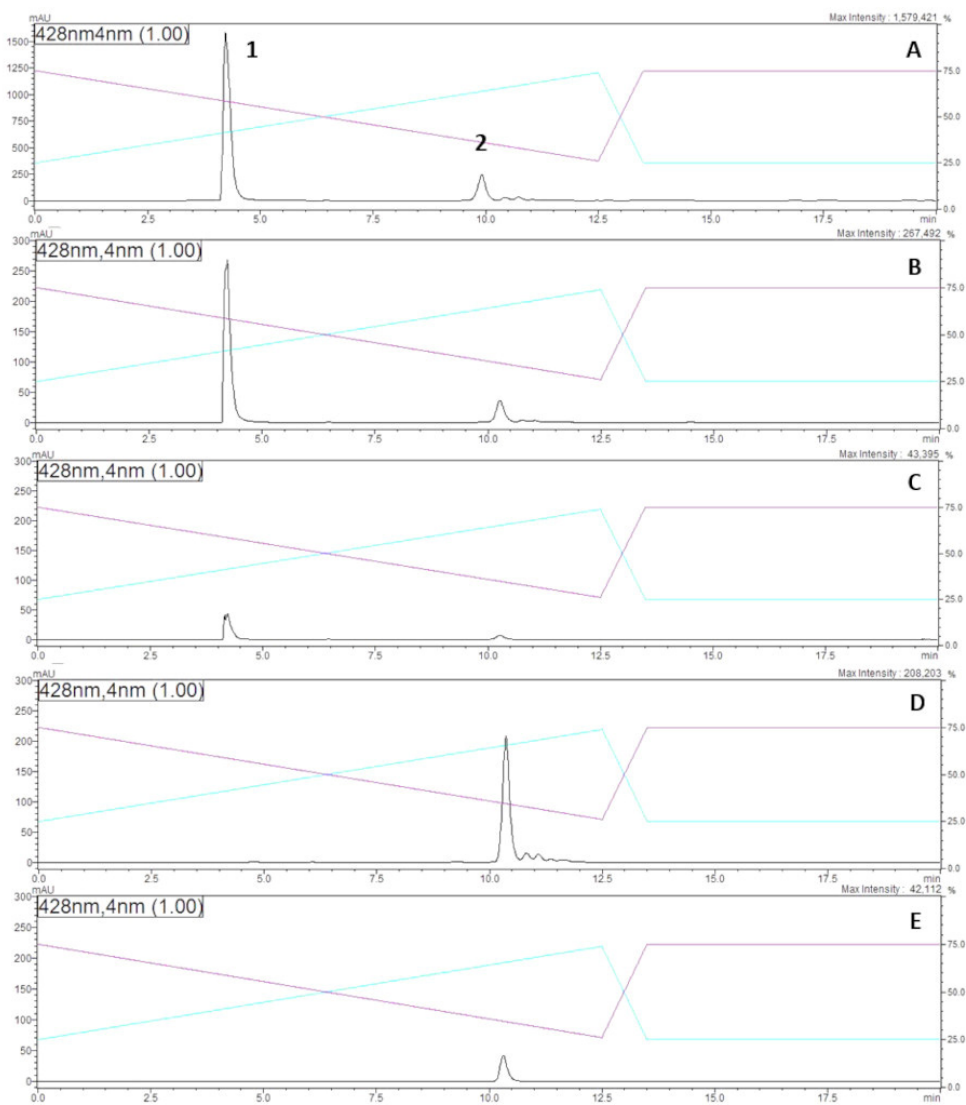
Figure 4. Semi-preparative HPLC-DAD chromatograms of SPE-purified crude methanol extract of Epicoccum nigrum recorded at 428 nm using a C18 column. Pink line: eluent A (H 2 O at pH 10); blue line: eluent B (methanol:isopropanol 8:2 v / v ). A : Two major peaks containing yellow compounds were observed at 4 min (peak 1) and 9.5 min (peak 2), in addition to a few minor peaks. B : Re-injection of peak 1 (from A ) dissolved in pure methanol. C : Re-injection of peak 2 (from A ) dissolved in pure methanol. D : Re-injection of peak 1 (from A ) dissolved in H 2 O. E : Re-injection of peak 2 (from A ) dissolved in H 2